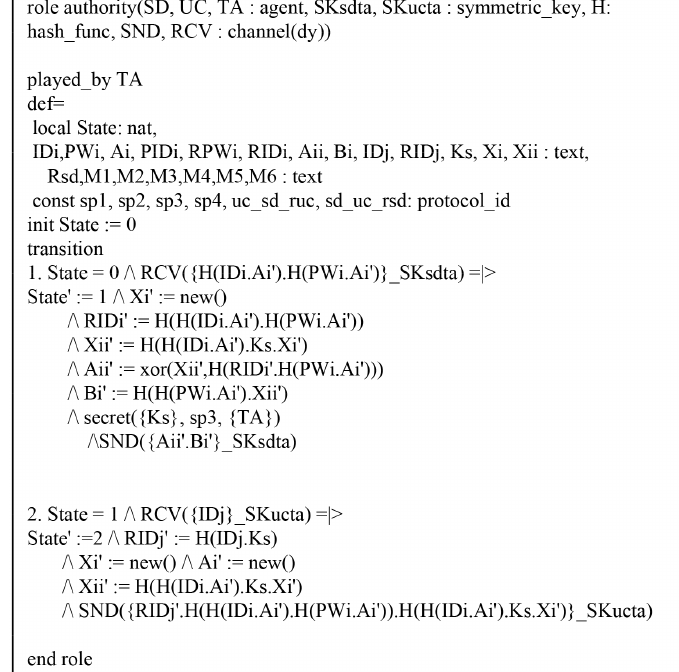
Figure 12. Role specification of trusted authority.